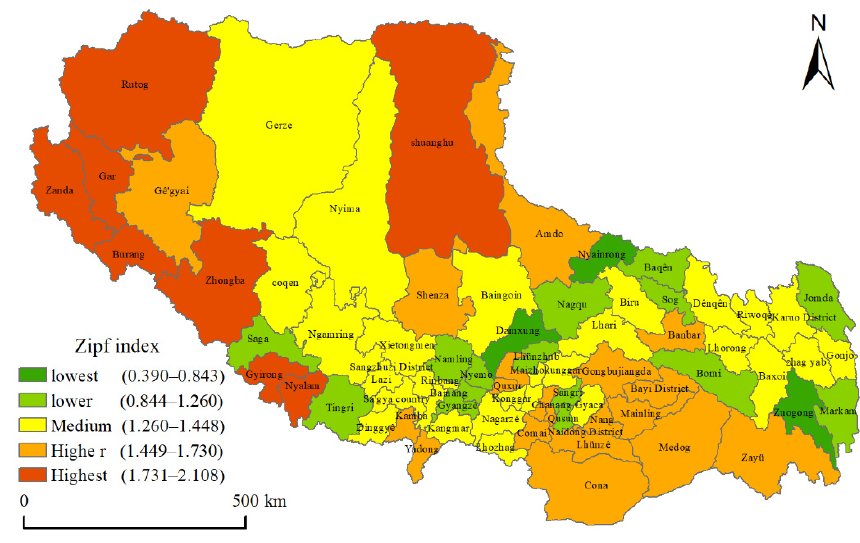
Figure 7. Zipf index spatial distribution